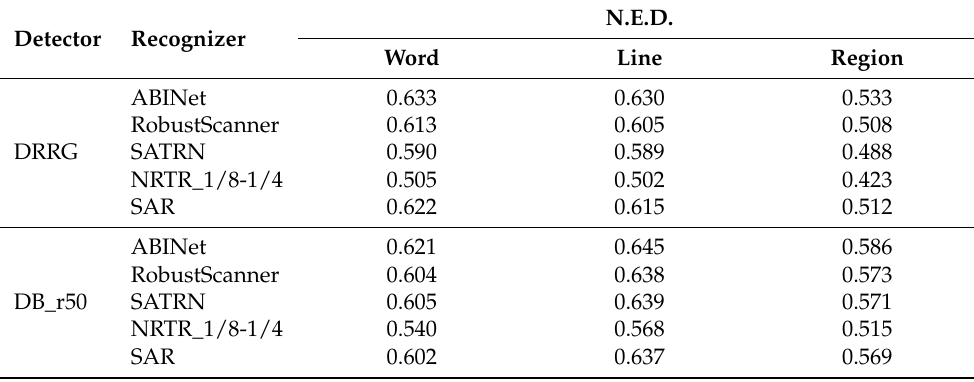
Table 2. Evaluation of two-step text